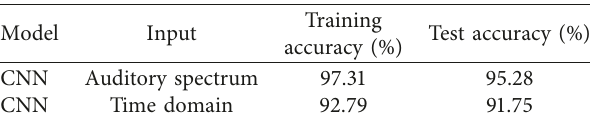
Table 4: Comparison of auditory spectrum and time-domain input test